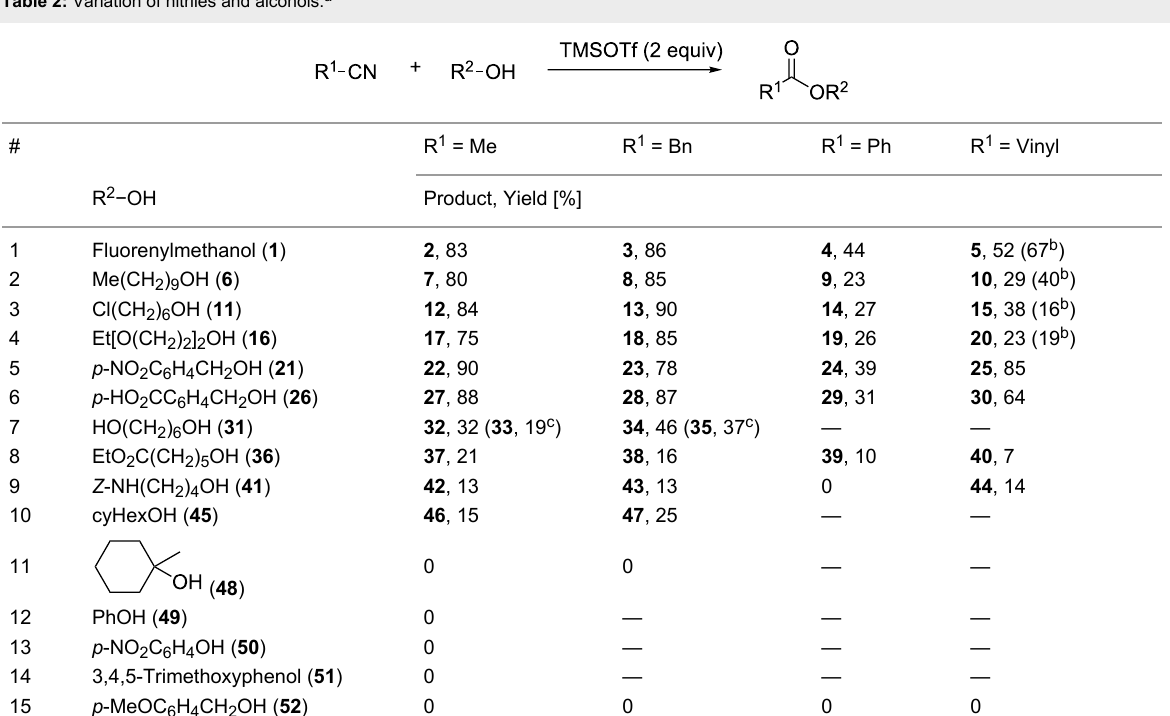
Table 2: Variation of nitriles and alcohols.